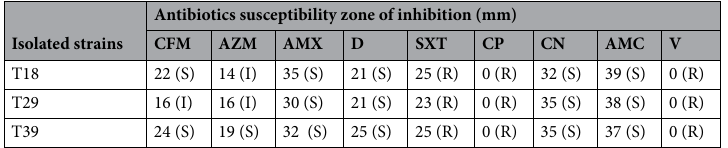
Table 4. Antibiotic susceptibility profiles of isolated LAB. Cefixime results based on R ≤ 15 mm; I: 16–18 mm; S ≥ 19 mm. Azithromycin results based on R ≤ 13 mm; I: 14–17 mm; S ≥ 18 mm. Amoxicillin results based on R ≤ 18 mm; I: 19–21 mm; S ≥ 22 mm. Doxycycline results based on R ≤ 10 mm; I: 11–13 mm; S ≥ 14 mm. Trimethoprim sulfamethoxazole results based on R ≤ 25 mm; I: 26–29 mm; S ≥ 30 mm. Ciprofloxacin results based on R ≤ 15 mm; I: 16–20 mm; S ≥ 21 mm. Cephalexin results based on R ≤ 14 mm; I: 15–17 mm; S ≥ 18 mm. Amoxicillin-clavulanic acid results based on R ≤ 13 mm; I: 14–17 mm; S ≥ 18 mm. Vancomycin results based on R ≤ 14 mm; I: 15–16 mm; S ≥ 17 mm. Performance Standards for Antimicrobial Susceptibility Testing, from Clinical and Laboratory Standards Institute, Twenty-Third Informational Supplement, Wayne, PA (CLSI 2013). CFM cefixime, AZM azithromycin, AMX amoxicillin, D doxycycline, SXT trimethoprim sulfamethoxazole, CP ciprofloxacin, CN cephalexin, AMC amoxicillin-clavulanic acid, V